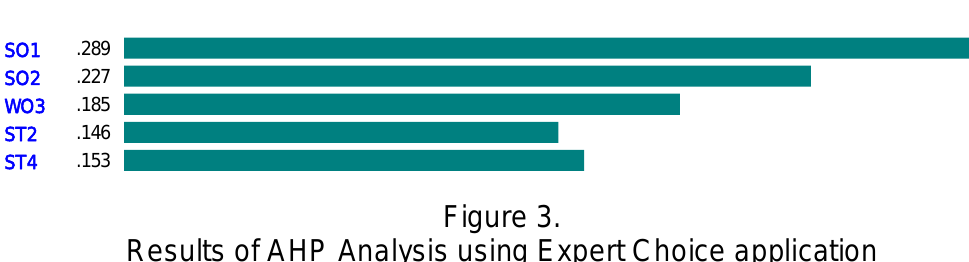
Results of AHP Analysis using Expert Choice